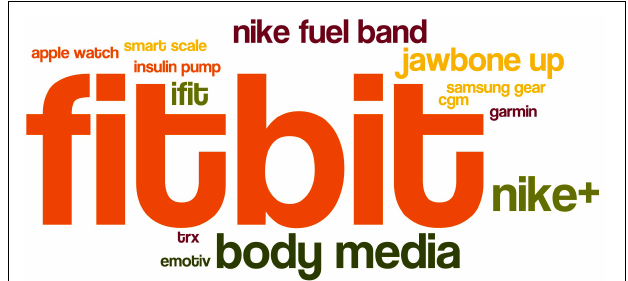
FIGURE 2 | Wearables used by study